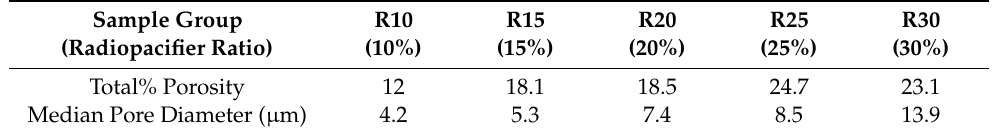
Table 5. Porosity of PMMA bone cement with different radiopacifier ratios. Sample Group